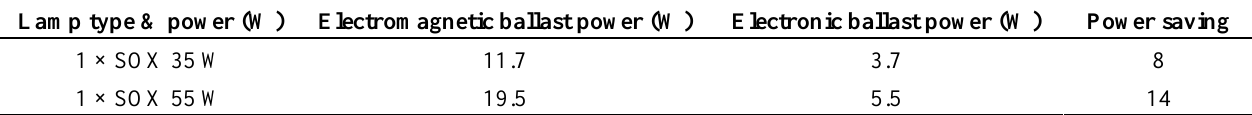
Table 4. Power savings using electronic ballasts with LPS lamps.